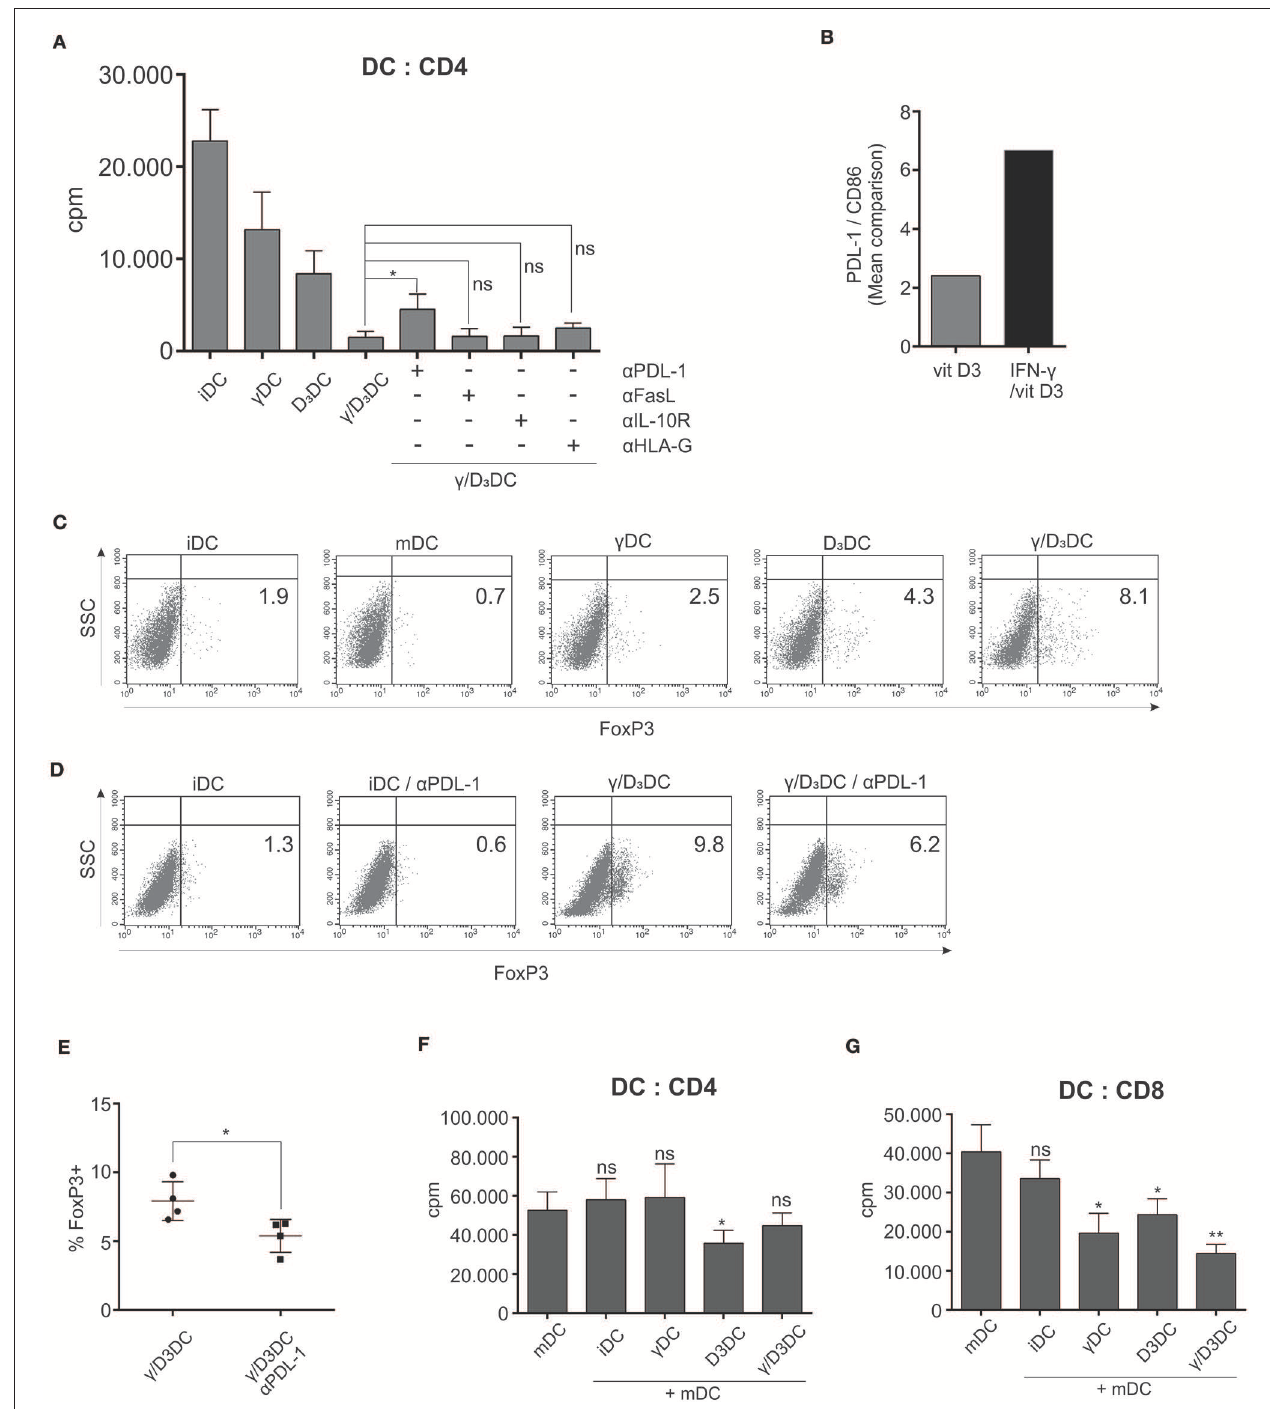
FIGURE 7 | PDL-1 is important for γ /D 3 DC’s function and their active immunosuppression is exerted primarily toward CD8 + T cells. (A) Differentially treated DCs were used as stimulators in an allogeneic mixed lymphocyte reaction. In parallel co-cultures, blocking mAbs were used against PDL-1, IL-10R, FasL, and HLA-G. After 5 days, cell proliferation was measured by liquid scintillation counting. Results are expressed as mean ± SD of determined counts per minute of four independent experiments. (B) The ratio of PDL-1 vs. CD86 expression is depicted for D 3 DCs and γ /D 3 DCs. The ratio was determined based on mean MFI values of analyzed markers. (C) The capacity of variously-treated DCs for induction of FoxP3 expression from naive T cells was determined. Dendritic cells were used as stimulators